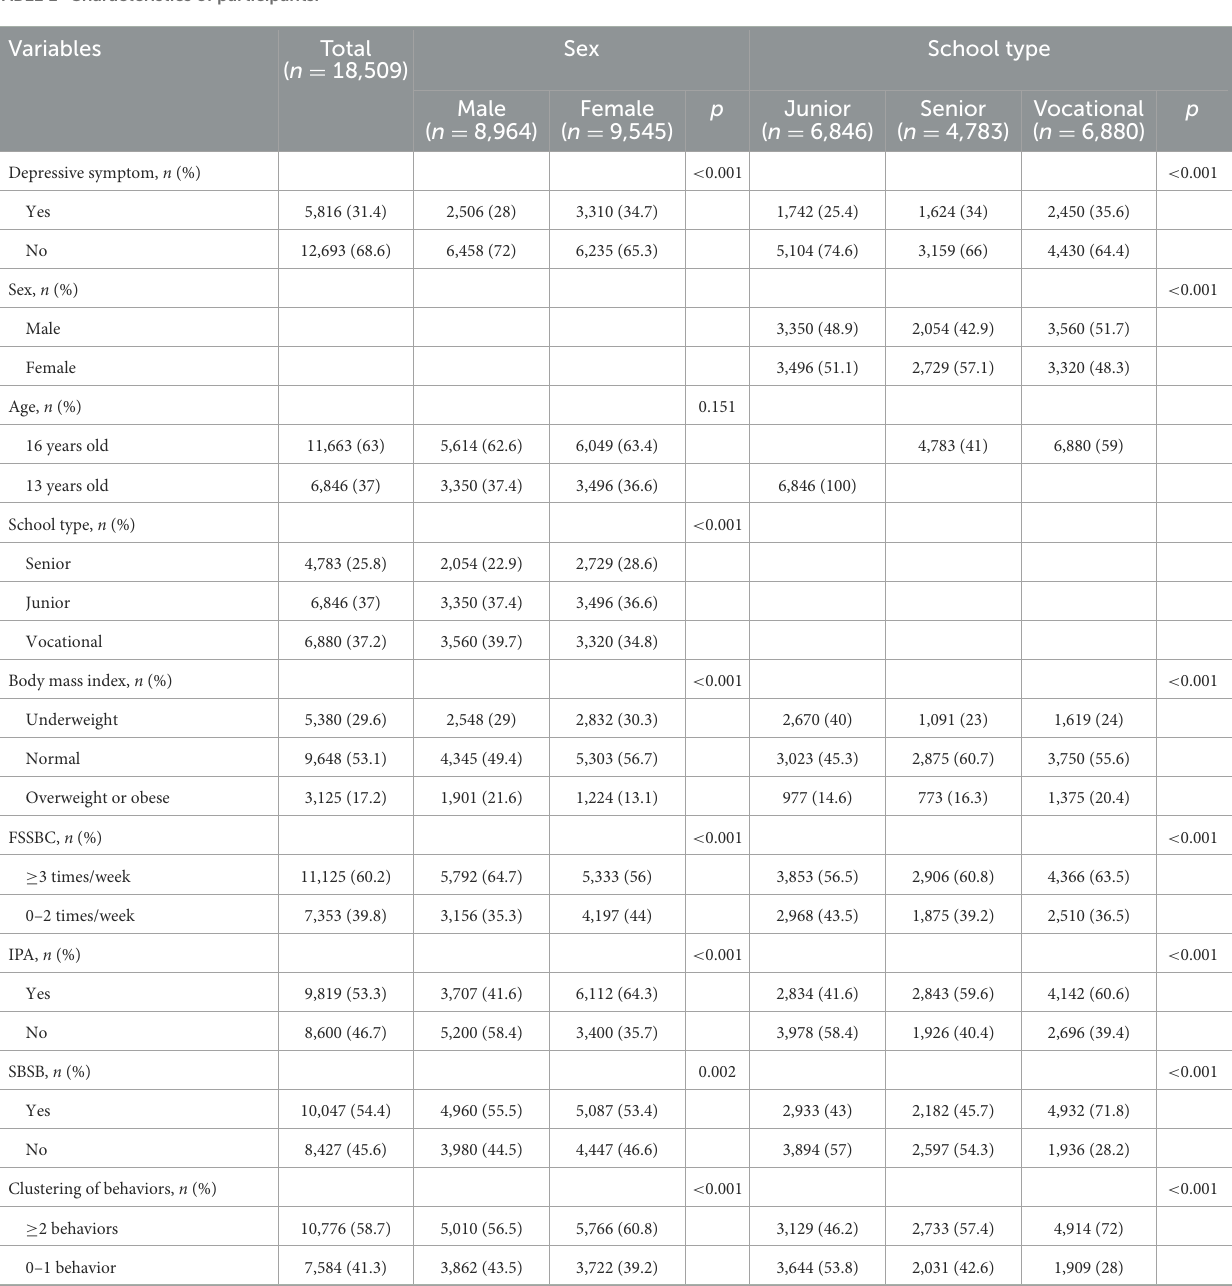
TABLE 1 Characteristics of